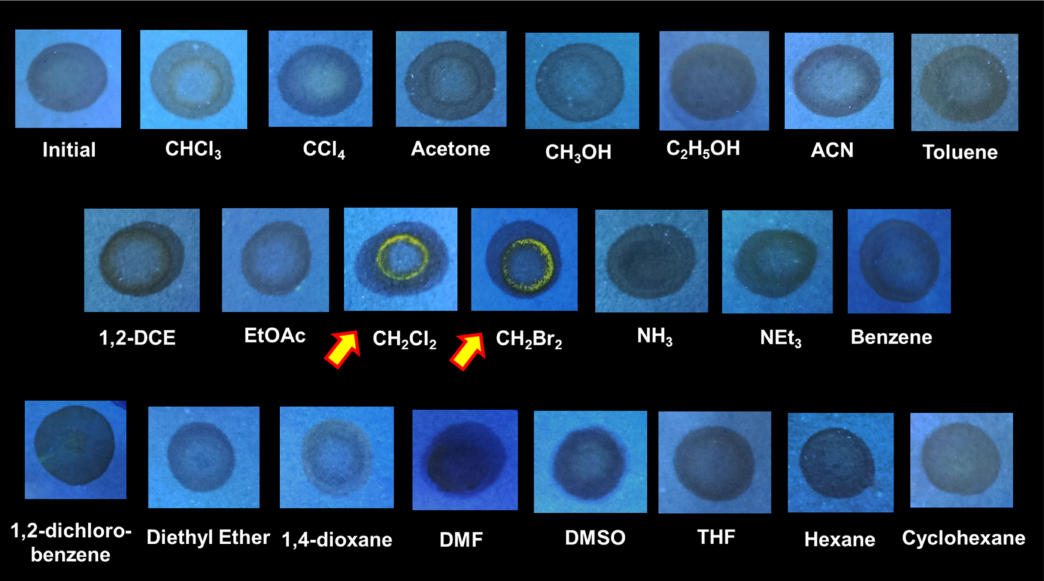
Figure 4. Photograph of selectivity test of M1 with the various solvents chloroform (CHCl 3 ), carbon tetrachloride (CCl 4 ), acetone, methanol (CH 3 OH), ethanol (C 2 H 5 OH), acetonitrile (ACN), toluene, 1,2-dichloroethane (1,2-DCE), ethyl acetate (EtOAc), dichloromethane (CH 2 Cl 2 ), dibromomethane (CH 2 Br 2 ), ammonia (NH 3 ), triethylamine (NEt 3 ), benzene, 1,2-dichlorobenzene, diethyl ether, 1,4- dioxane, N, N-Dimethylformamide (DMF), dimethyl sulfoxide (DMSO), tetrahydrofuran (THF), hexane, and cyclohexane on Whatman No 1 filter paper under UV lamp (365 nm) (The arrows indicate the turn-on emission response with dichloromethane and dibromomethane only).